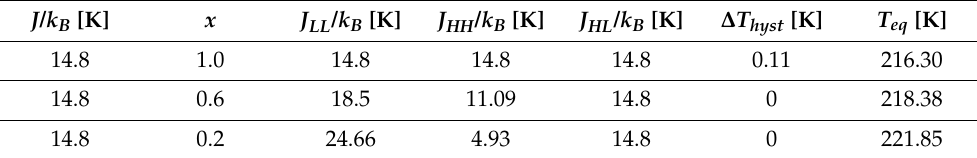
Table 4. Equilibrium temperatures and hysteresis widths calculated for different values of x = J HH / J LL parameter in a 6 × 6 square lattice. The computational parameters are: ∆ / k B = 1300 K, J / k B = 14.8 K, G / k B = 172.2 K and ln( g ) =